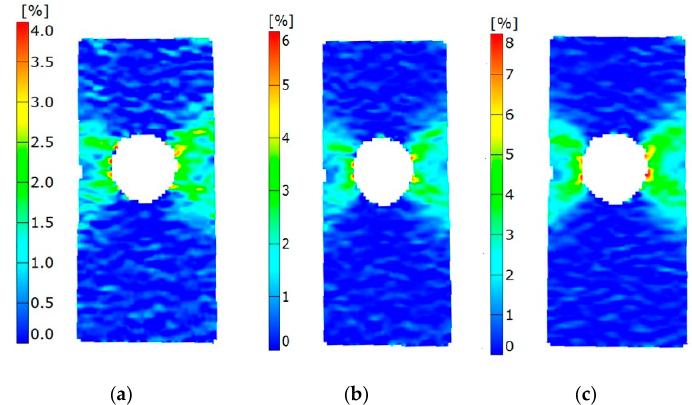
Figure 11. Experimental strain fields along the loading direction measured by the DIC technology in the ( a ) 1st cycle, ( b ) 10th cycle and ( c ) 20th cycle.